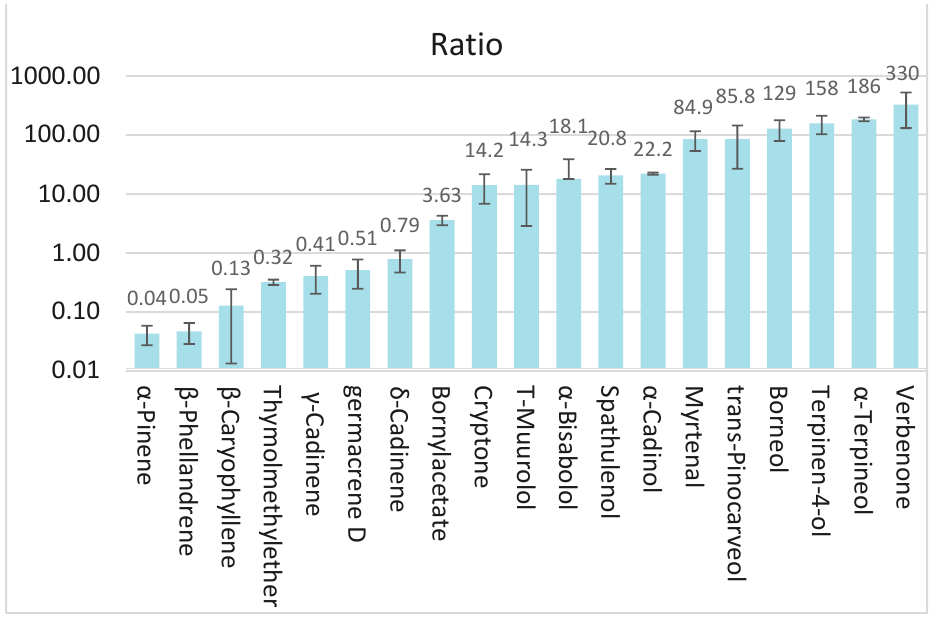
Figure 5. Ratio of volatile percentage in hydrolates to essential